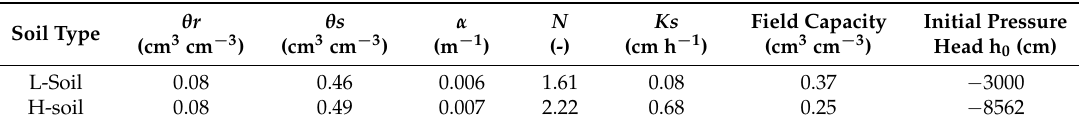
Table 1. Hydraulic parameters of L-soil and